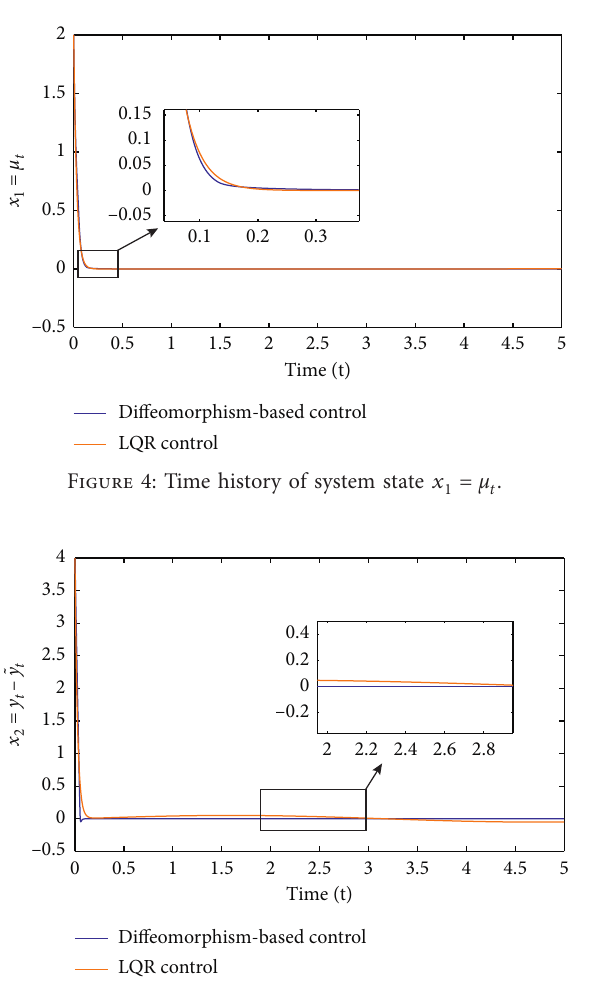
Figure 5: Time history of system state x